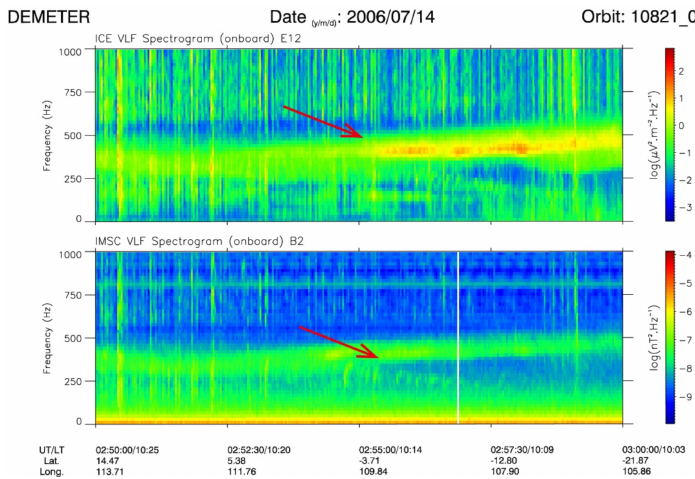
Figure 15. Electric and magnetic field spectrogram for 14 July 2006 (orbit 10,821 downward). From top to bottom, the first panel shows the results of the electric field spectrogram up to 1 kHz, and the second one displays the magnetic results up to 1 kHz, where perturbations are highlighted by the red